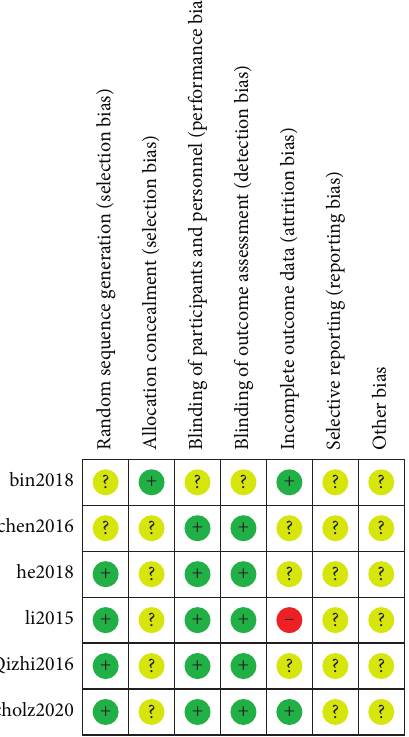
Figure 3: Literature quality evaluation chart of RCT. Table 2: Newcastle-Ottawa Scale evaluation of observational studies. Methodological quality assessment for inclusion in observational studies (score) Study population Research